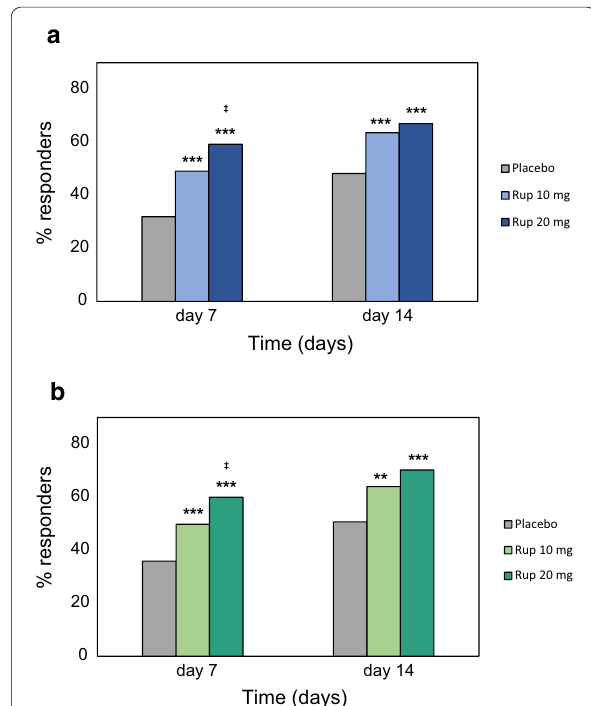
Fig. 4 Proportion of patients achieving the complete/ near-to-complete response after treatment with rupatadine 10 mg or 20 mg for T4NSS and T6SS. Data are expressed as percentage of patients achieving the complete/near-to-complete endpoints: a complete/near-to-complete reduction was defined as T4NSS score 2 and each symptom score 1, b complete/ ≤ ≤ near-to-complete reduction was defined as T6SS score 3 and each ≤ symptom score 1. Statistical significance was calculated with the ≤ Mann–Whitney test. *** p < 0.001; ** p < 0.01 (rupatadine groups